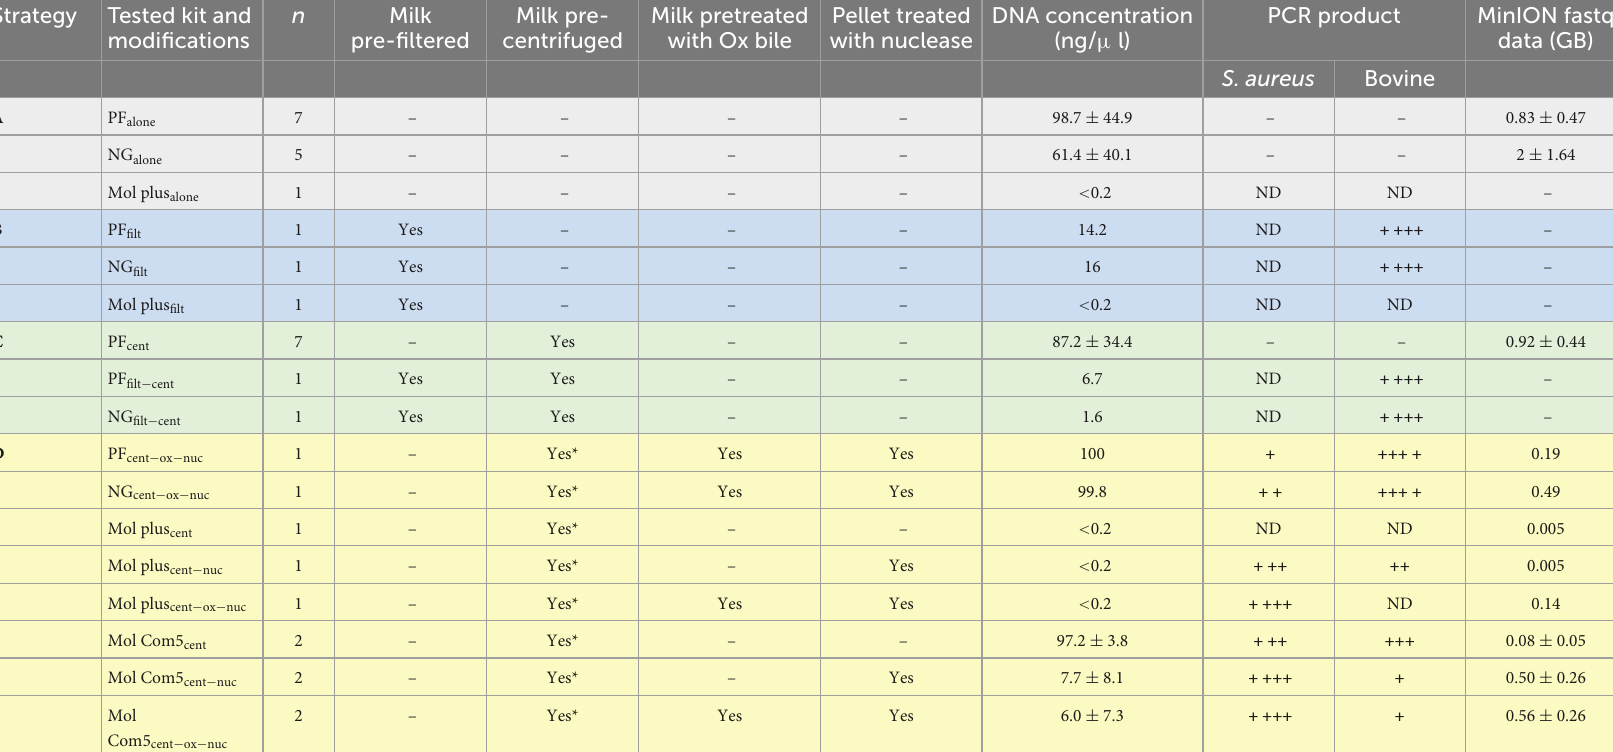
The strategies are highlighted by different background colors. The abbreviation describing each combination and condition is given in the kits and combination column. Data presented as mean ± SD. The – symbol indicates that the step or experiment wasnotperformed. ND indicatesnoPCRbandwasdetectedandthe+signshowstheintensityofthePCRband(product).The Yes signshowsthelow-speedcentrifugation(400 × g for10minatroomtemperature)andthe Yes* signshowscentrifugation at4,500 × g for20minat4 ◦ CfollowedbytwowashingstepsinPBS.Thenumberofsamplesisgivenby n